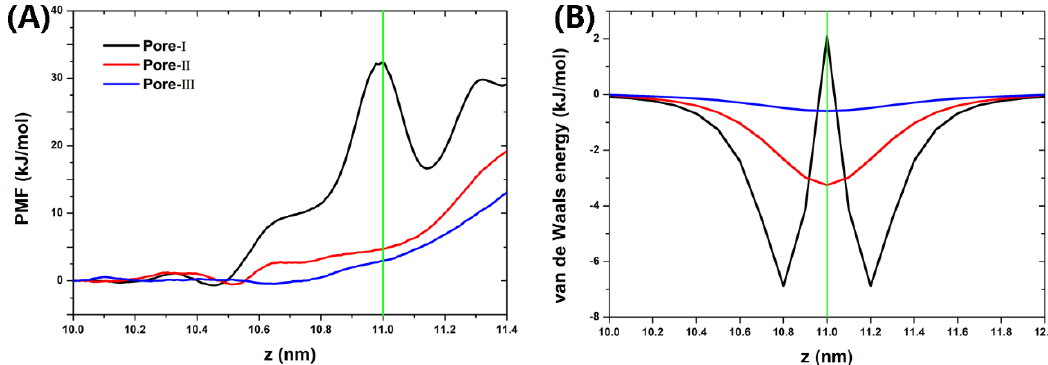
Figure 3. Potential of mean force (PMF) profiles of water passing through the nanopores of graphene along the z -axis ( A ). The van de Waals energy between the water and the graphene nanopore ( B ). The green vertical lines represent the position of graphene walls. For PMF profiles, the z < 11.0 nm region represents nanocavities containing water droplet, and the z > 11.0 region represents the vacuum chamber.